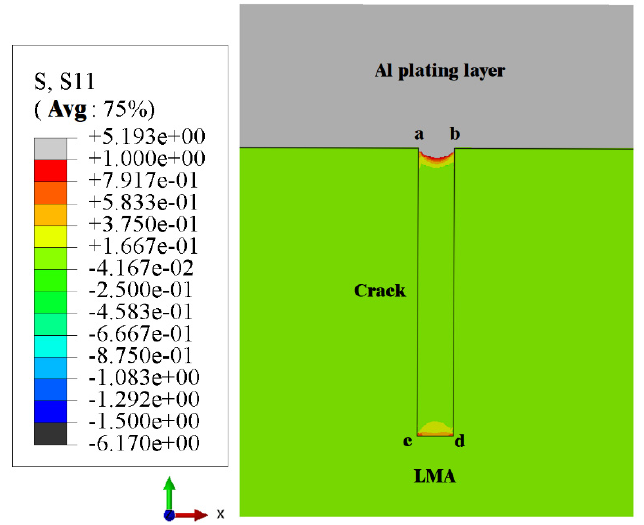
Figure 10. Shear thermal stress cloud diagram at the top and bottom of M2S2 cracks “maintained at 1200 ◦ C”. Table 6. Maximum and minimum thermal stresses in each direction on the sidewall of M2S2 cracks at the “maintained at 1200 ◦ C” situation.